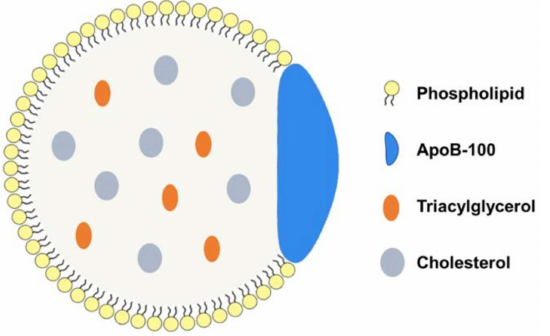
Figure 1. Schematic diagram of LDL structure. LDL is composed of phospholipid monolayers, cholesterols, triglycerides, and ApoB-100.